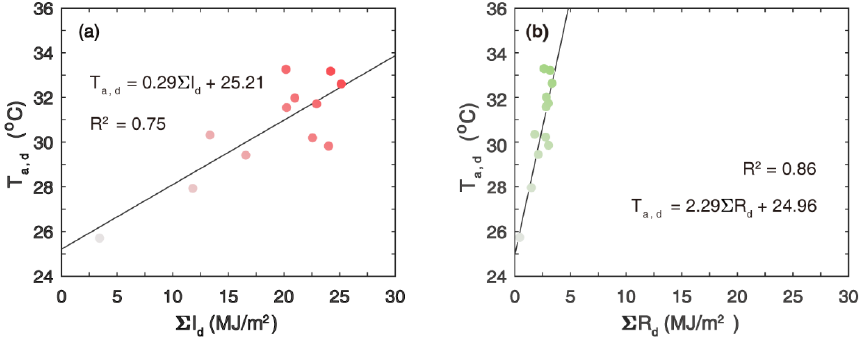
Figure 5. The daily near-ground air temperature (T a,d ) corrected with ( a ) Σ I d and with ( b ) Σ R d .